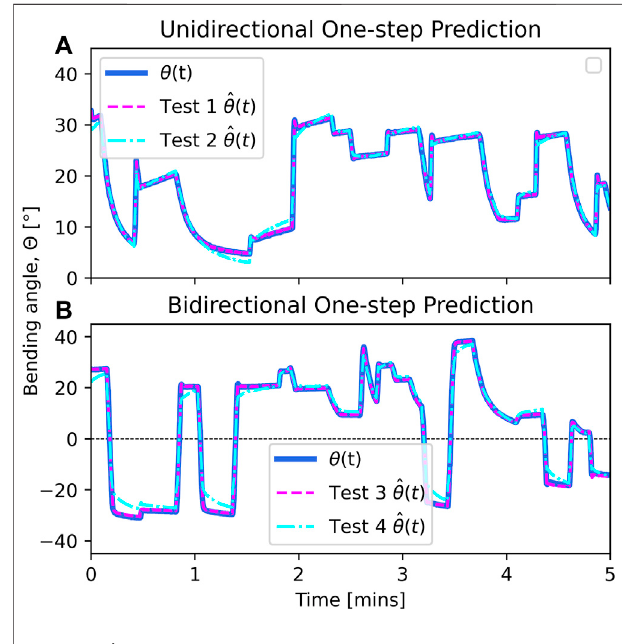
FIGURE 5 | Predictions of each model one time-step into the future. (A) Models trained on unidirectional data using both PWM duty cycle and temperature as inputs, i.e., v 1,2 . (B) Corresponding models trained on bidirectional data, v 3,4 . Signals are virtually identical, indicating that one- step predictions are extremely